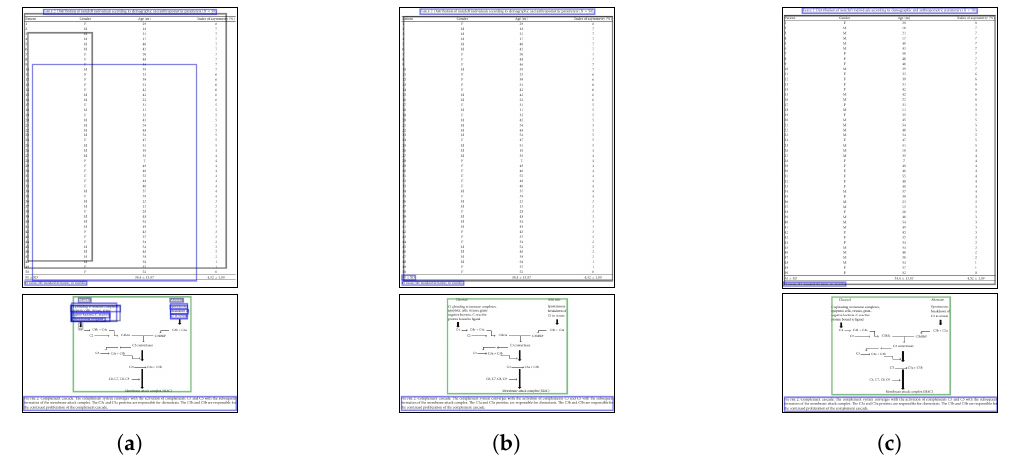
Figure 7. Detection results of PublayNet from baseline, Faster-RCNN+ResNet-50+DyHead, and the Faster-RCNN+ConvNeXt+DyHead model. The colors blue, black, and green represent paragraphs, tables, and figures, respectively. ( a ) The samples obtained from the baseline model with Faster-RCNN using ResNet-50 as the backbone. ( b ) The samples obtained with the attention mechanism incorpo- rated into the pipeline of the baseline model. ( c ) The detections by Faster-RCNN+ConvNeXt+DyHead model. The detections are clean and accurate with the inclusion of the attention mechanism. Further- more, DyHead and ConvNeXt prove to detect the objects better compared to its counterparts with fewer nested detections.